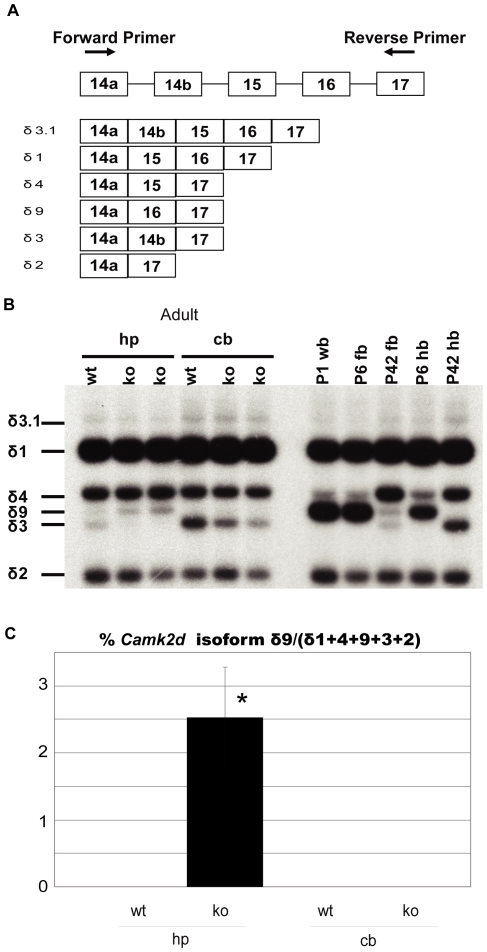
Spatial and temporal differences in the expression of Camk2d.(A) Transcripts of Camk2d. (B) Representative PCR products. Six spliced isoforms were detected by using primer pairs located in exons 14a and 17. Right panel shows isoform switching from δ9 to δ4 during the fetal (P1, P6) to adult (P42) transition in whole brain (wb), forebrain (fb) and hindbrain (hb) whereas the δ9 isoform was undetectable in adult hindbrain. Left panel shows a detectable increase in the δ9 isoform in Mbnl1
ΔE3/ΔE3 hippocampus (hp) compared with wild-type sibs. However, no δ9 isoform could be detected in the cerebellum of either wild-type or Mbnl1 knockout mice. (C) The percentage of Camk2d isoform δ9 to δ1+4+9+3+2. Both unpaired t-test and permutation test were used for calculating p value (n = 3, *p value<0.05). Averages and standard deviations were generated by unpaired t-test.